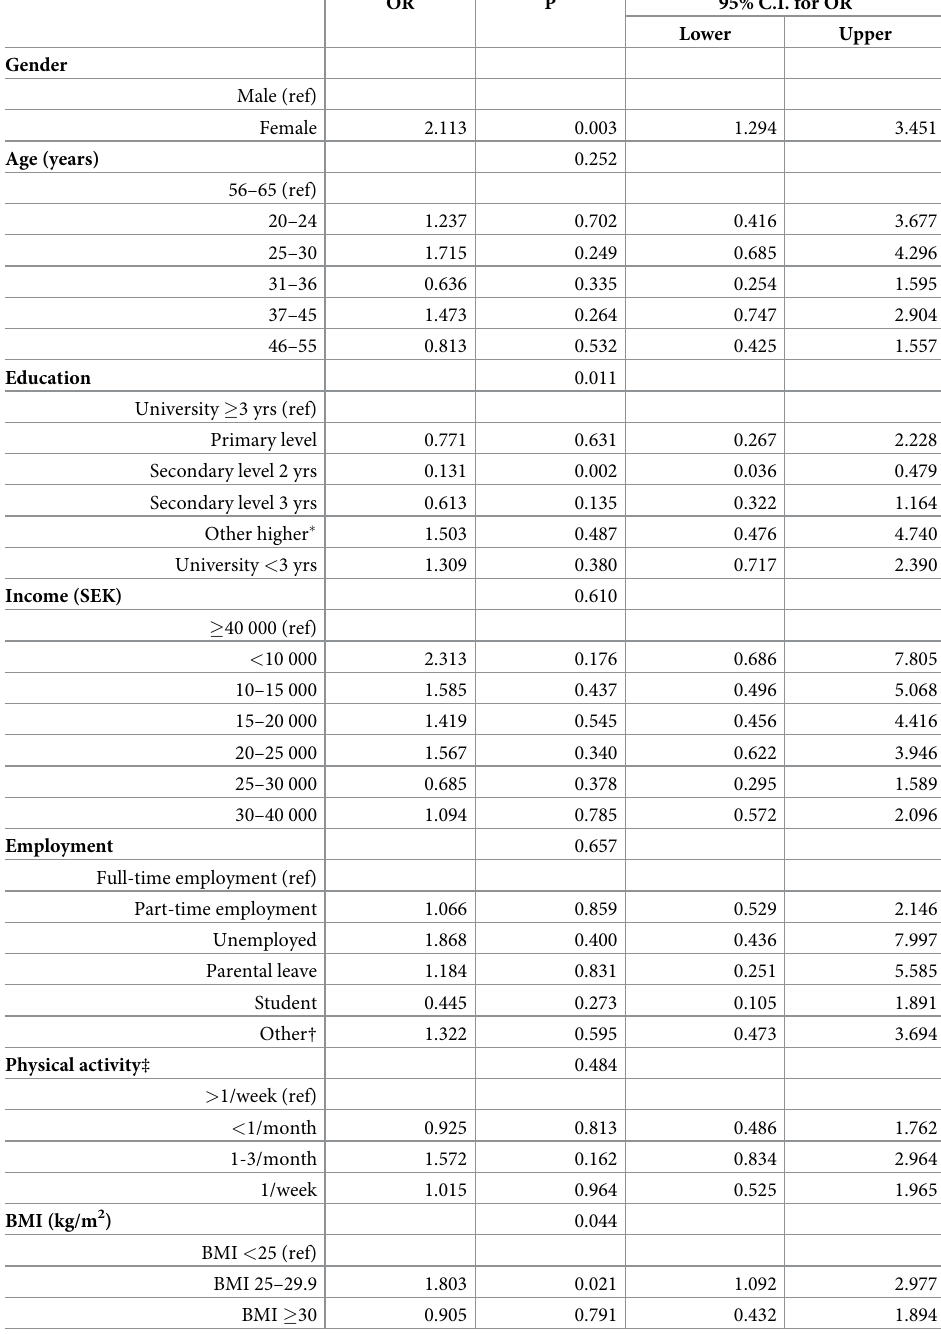
Table 3. Determinants of following a specific dietary regimen in multivariable logistic regression analysis (N = 555). OR P 95% C.I. for OR Lower